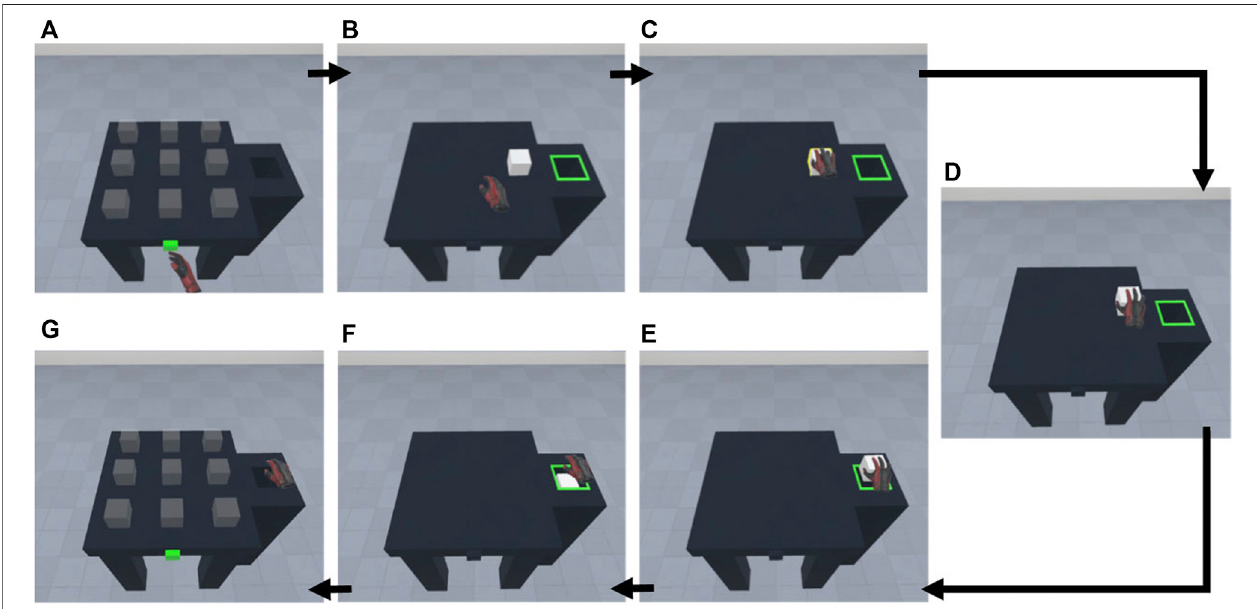
FIGURE 3 | The steps to completing a task: clockwise from (A) pushing the button, (B) viewing active cube, (C) grabbing cube, (D) moving attached cube, (E) aligning cube to hole, (F) dropping cube in hole, and (G) viewing all cubes to restart.